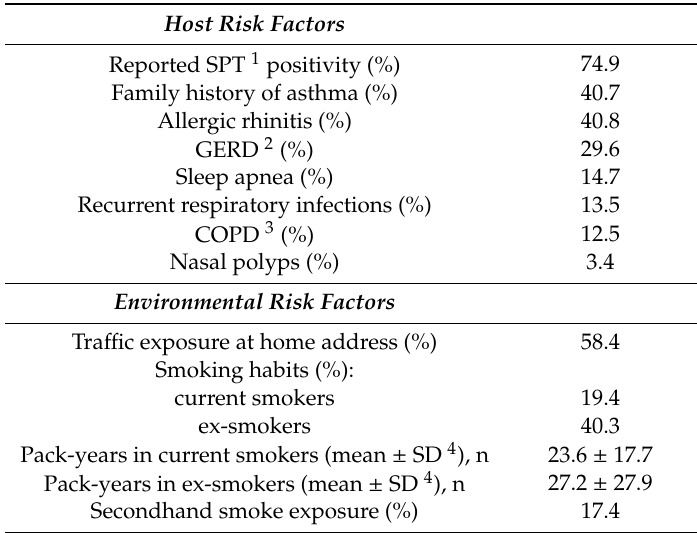
Table 2. Baseline host and environmental risk factors of the investigated subjects ( n =